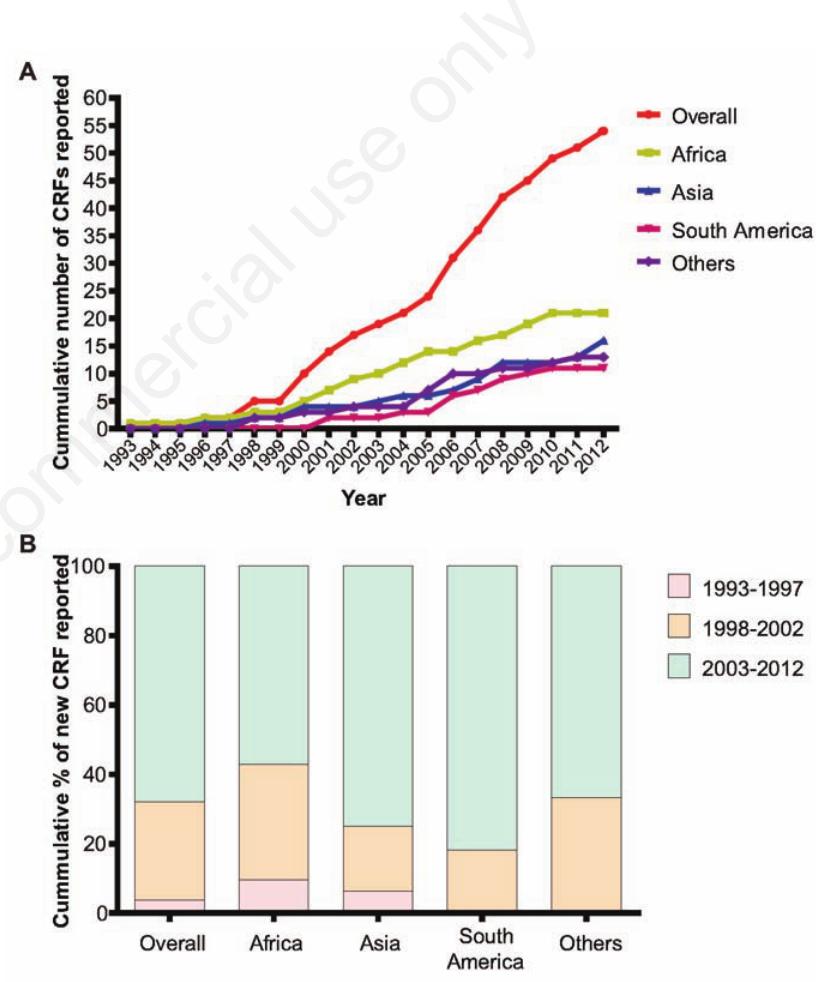
Figure 2. Circulating recombinant forms (CRFs) of HIV-1 identified globally in the past 20 years. (A) Cumulative number of CRFs reported yearly in major geographical regions (Africa, Asia, South America) and globally (Overall). (B) Cumulative percentage of novel HIV-1 CRFs discovered from 1993 to 2012. In all geographical regions and overall, marked increase in the percentage of newly discovered CRFs was observed in the last 10 years (years 2003-2012). Data were extracted from the Los Alamos HIV Database. CRF5501B was excluded from this analysis since data related to this CRF is not publicly